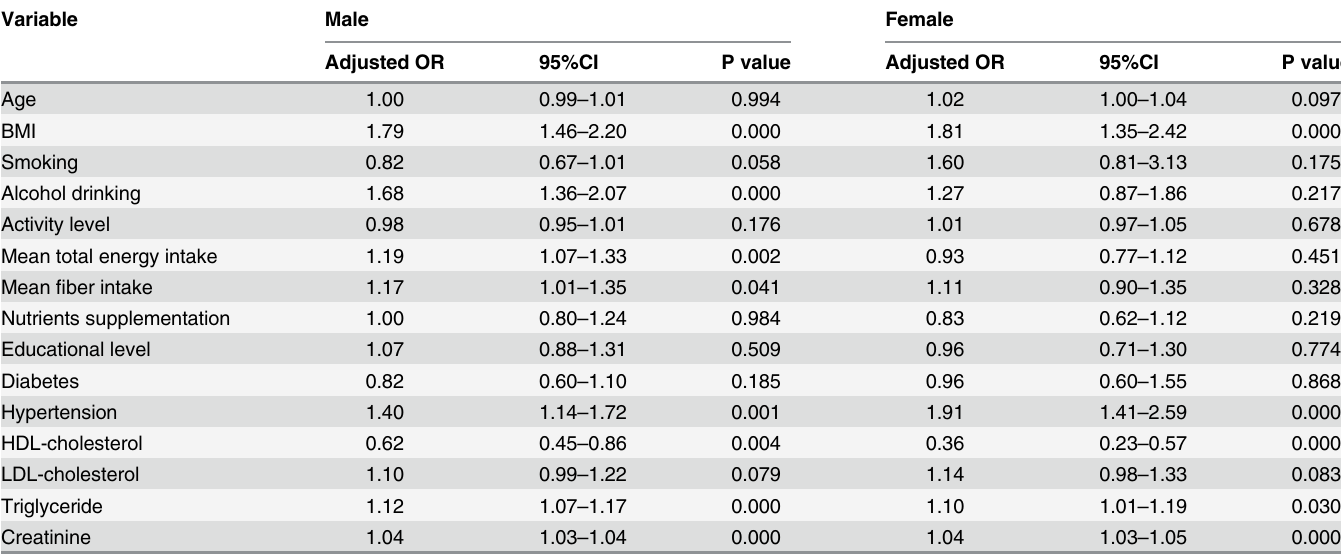
Table 1. The associations between potential confounding factors and HU in multivariable-adjusted